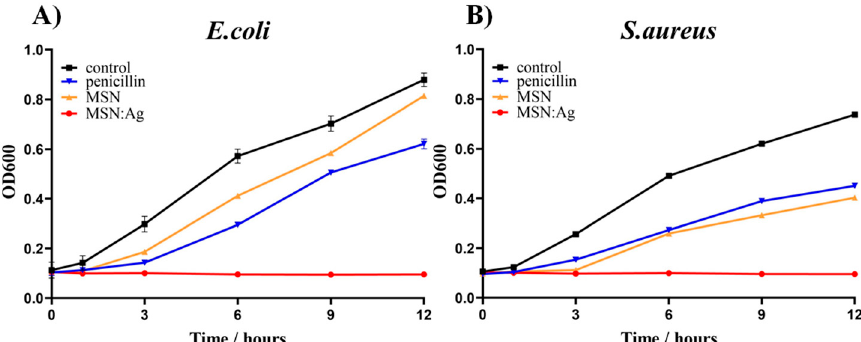
Figure 3. Inhibitory effects of MSN/Ag, MSNs, and penicillin at 1 mg/mL on the growth of E. coli ( A ) and S. aureus ( B ) in nutrient broth (NB) liquid media. Bacterial growth was monitored by measuring OD 600 . Each condition was prepared in triplicate. Each data point represents an average of three parallel samples, and the error bars indicate 1 standard deviation from the mean.